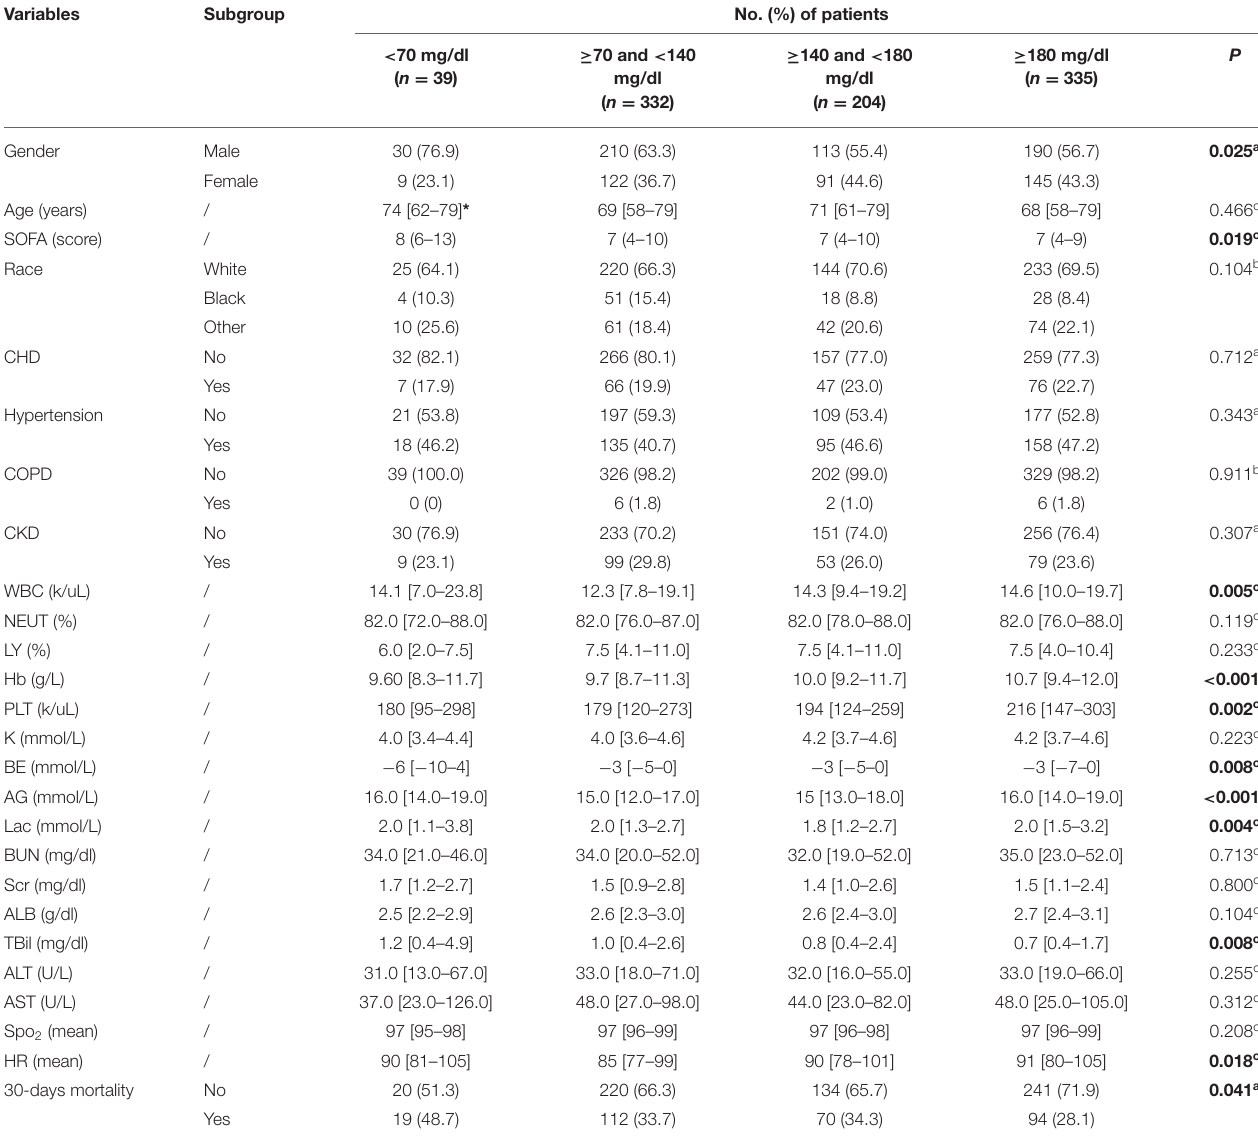
TABLE 1 | The demographic characteristics of septic patients with diabetes in different blood glucose levels.